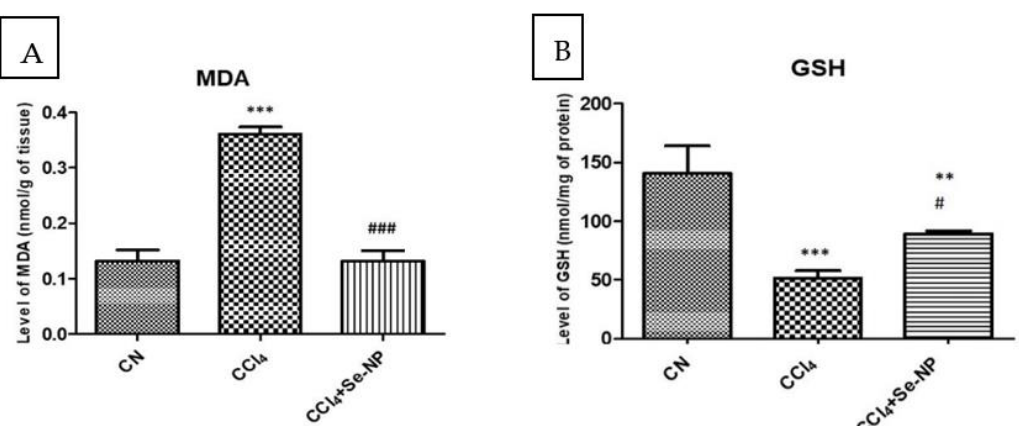
Figure 3. Hepatic oxidative stress parameters (malondialdehyde ( A ) and reduced glutathione ( B )) in rat liver in different treatment groups. * ( p -value < 0.05) indicates significant differences in other rat groups in comparison to control (CN) group animals. # ( p -value < 0.05) indicates significant differences in different rat groups compared to the CCl 4 group animals. Also ** and ## indicate p ≤ 0.005 while *** and ### indicate p ≤ 0.001.